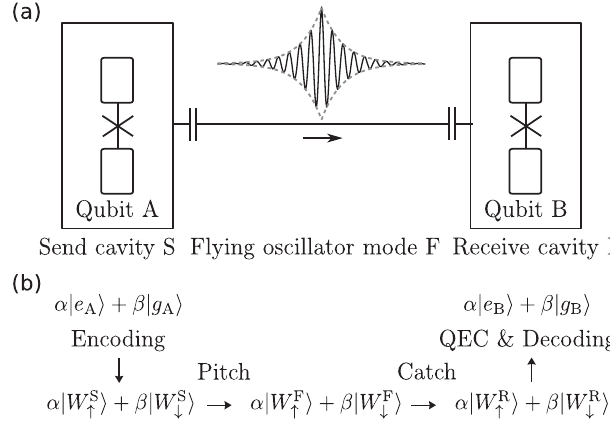
FIG. 3. (a) Sketch of a circuit QED hardware proposal and (b) schematic of a quantum-state transfer scenario utilizing quantum error correction for the binomial quantum code words. First, the state of qubit A is encoded in the send cavity S using code words j W S ↑ ; ↓ i . The state in S is allowed to leak into the flying oscillator mode F (pitch). By controlling the cavity decay rate, one can precisely tune a time-reversal symmetric temporal mode such that the quantum information is fully absorbed in the receiving cavity R (catch). Before decoding the received cavity state to the qubit B, the fidelity of the transfer process can be improved by a round of QEC in the received cavity